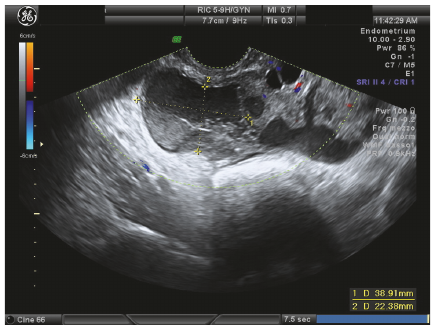
Figure 2: Case four: left adnexal mass (1).